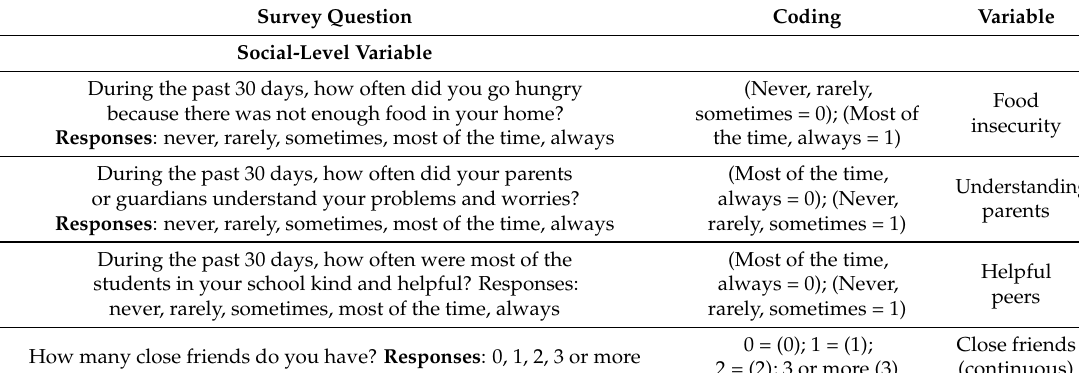
Table 2. Independent variable derivation from GSHS survey data Kuwait